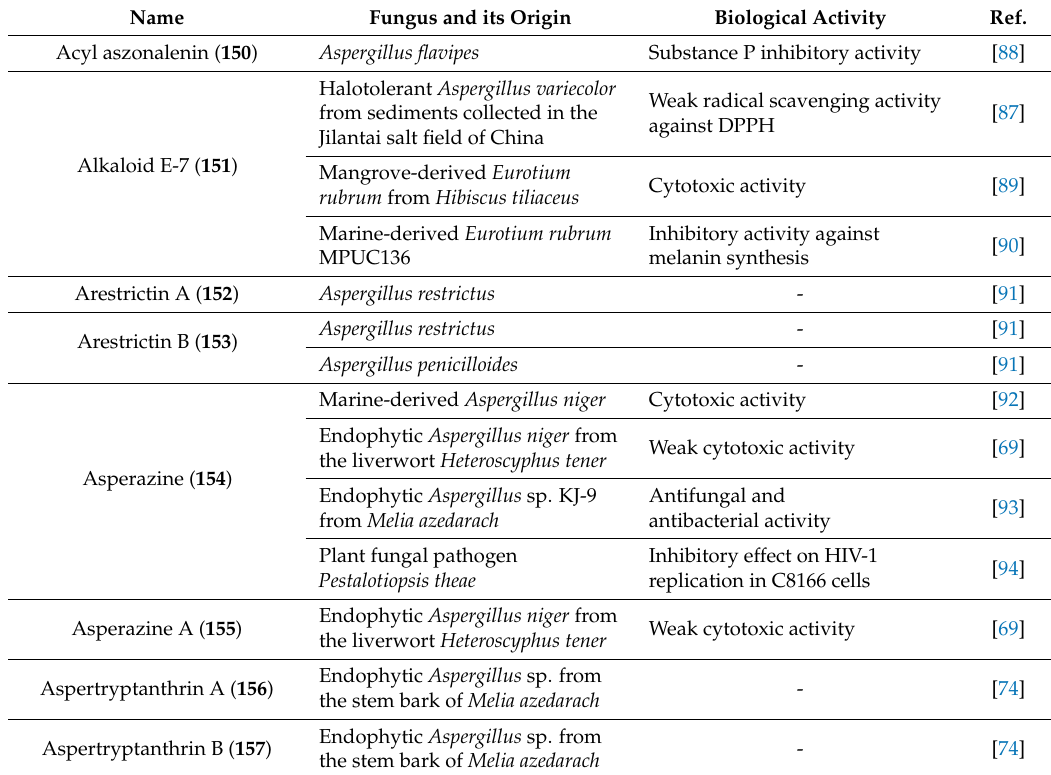
Table 3. Fungal tryptophan-Xaa cyclodipeptide analogs and their biological